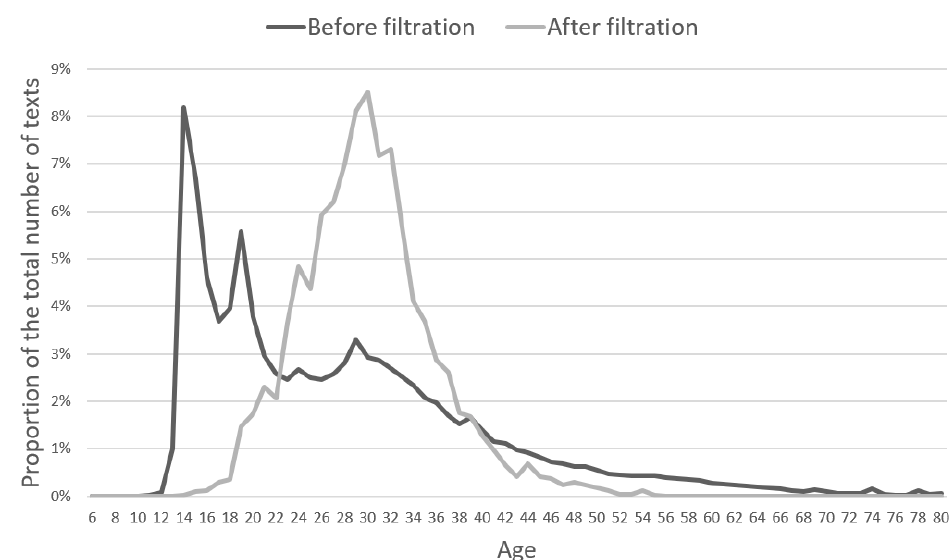
Figure 2. Distribution of users by age before and after filtering.